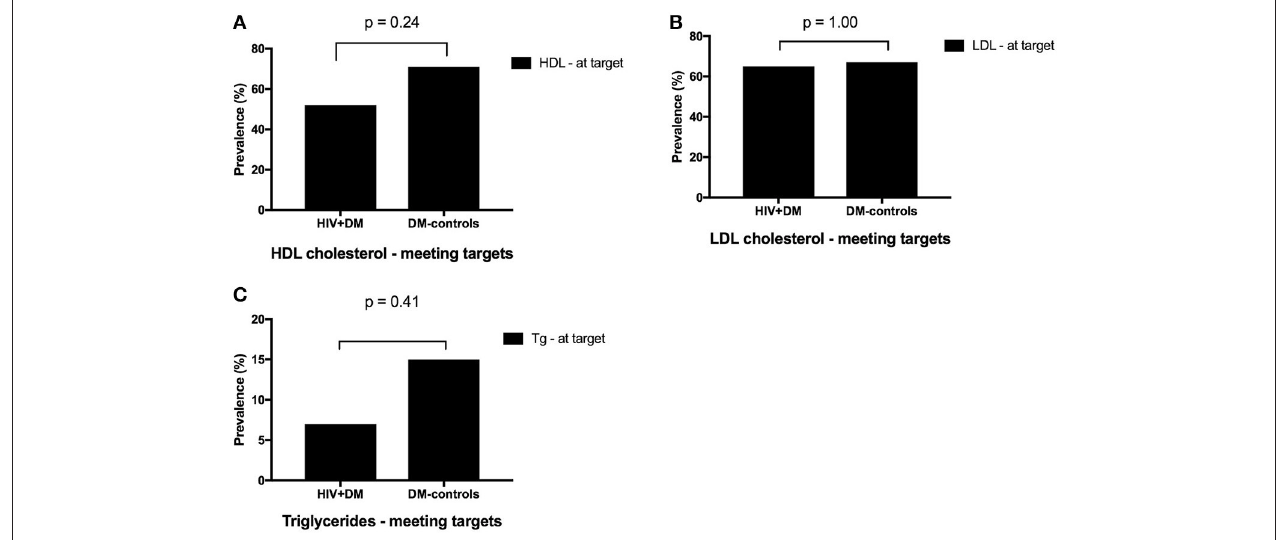
T2DM group ( n = 21, p = 0.05). All with T1DM were on insulin compared with 27% in T2DM group ( n = 7, p = 0.012). The systolic blood pressure was lower in the T1DM group than T2DM group (118 ± 3.0 vs. 127 ± 9 mmHg, respectively, p = NS) as well as the diastolic blood pressure (68.8 ± 9 vs. 78.6 ± 7 mmHg, respectively, p = 0.018). They were similar to each other for all